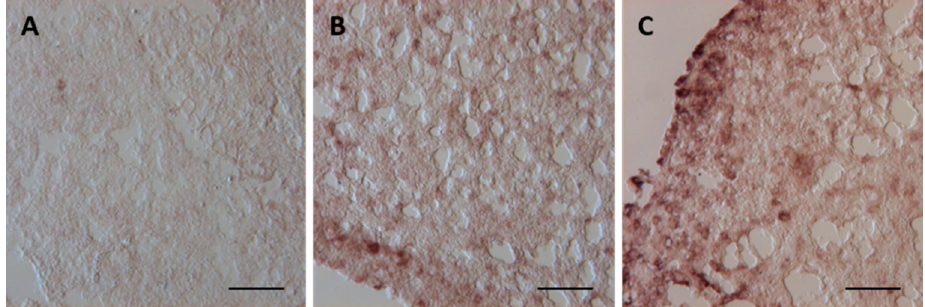
Figure 7. Mt mRNA expression assessed by in situ hybridization on Danio rerio liver cryosections. ( A ) Weak mt mRNA hybridization signal in the control samples; ( B ). After 96 h of exposure to 7.7 μ g/L of HgCl 2 , the cytoplasmic areas of the hepatocytes show positive hybridization signal; ( C ) Increase in hybridization signal in liver from animals exposed to 38.5 μ g/L of HgCl 2 . All bar 45 μ m.